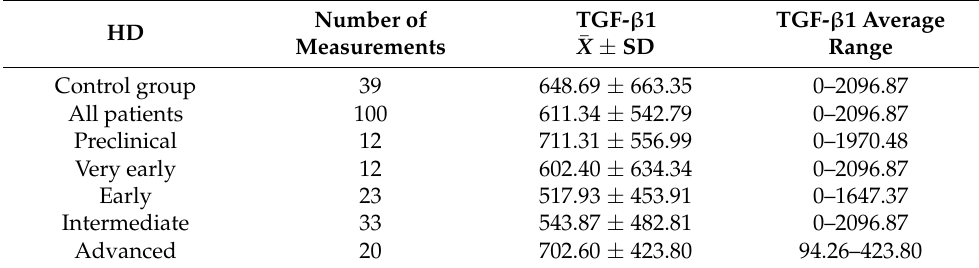
Figure 2. Plasma levels of TGF- β 1 in the individual HD stages and control group. Table 4. Plasma levels of TGF- β 1 in the control group and HD